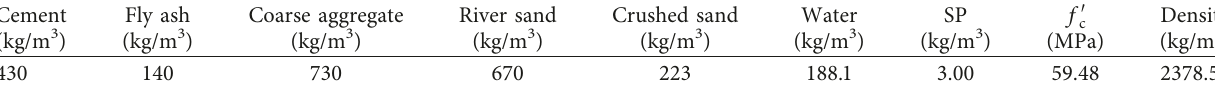
Table 1: Mix proportions and properties of self-compacting concrete (SCC).